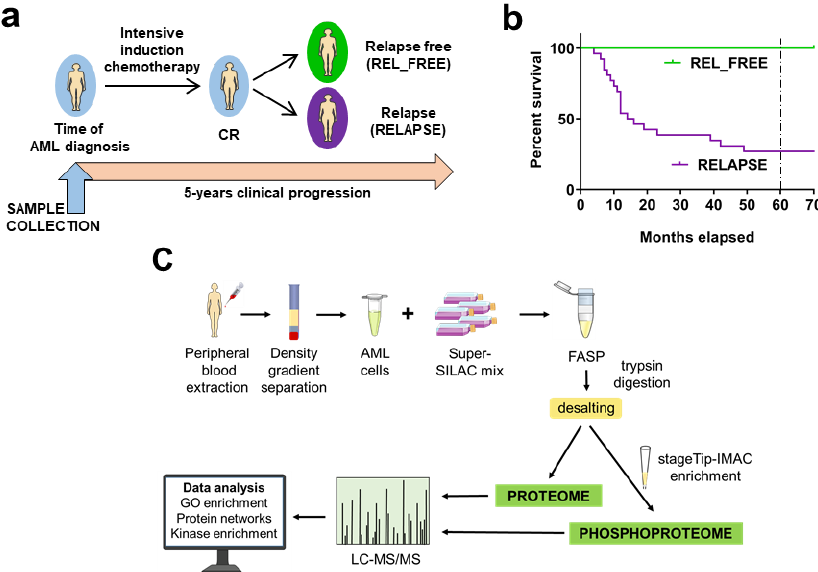
Figure 1. Overview of the RELAPSE and REL_FREE AML patient cohort and the workflows for the proteome and phosphoproteome analysis of acute myeloid leukemia (AML) patient cells. ( a ) The study included AML cell samples from 26 RELAPSE and 15 REL_FREE patients collected at the time of first diagnosis. All patients received intensive induction chemotherapy, consolidation therapy and achieved complete remission (CR), as described in Materials and Methods. Patients were classified after an observation time of at least five years from the initial therapy. ( b ) Survival plot for the patients included in each group. Dashed line indicates the five-years observation time. ( c ) AML sample preparation steps for proteome and phosphoproteome analysis include blood extraction, blast isolation, cell lysis, addition of super-SILAC (Stable Isotope Labeling with Amino Acids in Cell Culture) mix, filter-aided sample preparation (FASP)-based protein digestion and additional immobilized metal a ffi nity chromatography (IMAC) enrichment of phosphopeptides. After liquid chromatography tandem mass